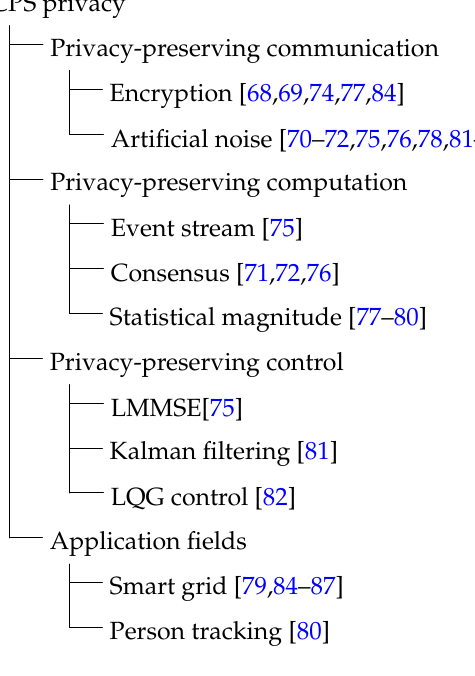
Figure 3. A summary of CPS